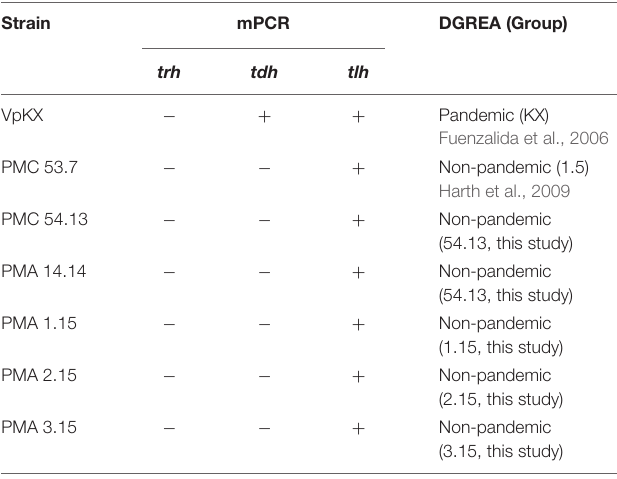
TABLE 2 | Strain characterization and classification according to mPCR and DGREA.